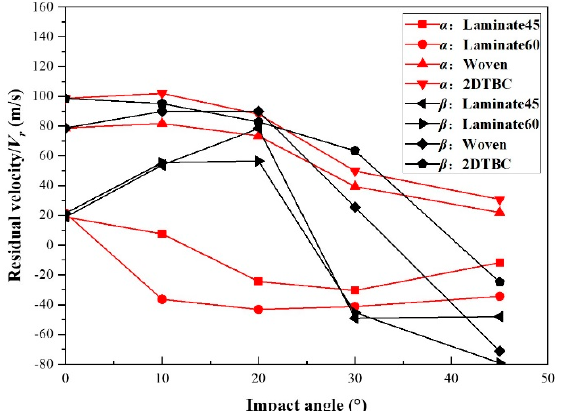
Figure 12. The relationship between deflection angle α , β , and projectile residual velocity for panels impacted under V n = 125 m / composites panels impacted under V n = 125 m/s.